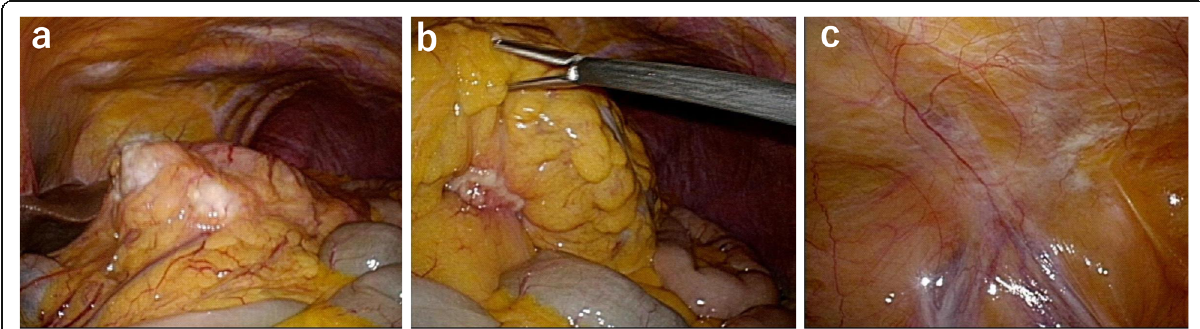
Fig. 2 Laparoscopic images before combined therapy. a There are bulky regional lymph node metastases. b The transverse mesocolon is invaded by tumor. c Disseminated nodules are seen on the peritoneal surface